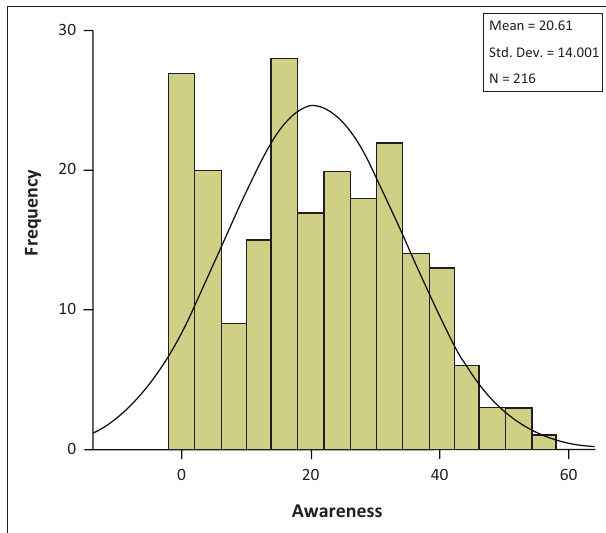
FIGURE 4: Distribution of respondents based on their awareness of exposure to radiation ( n =